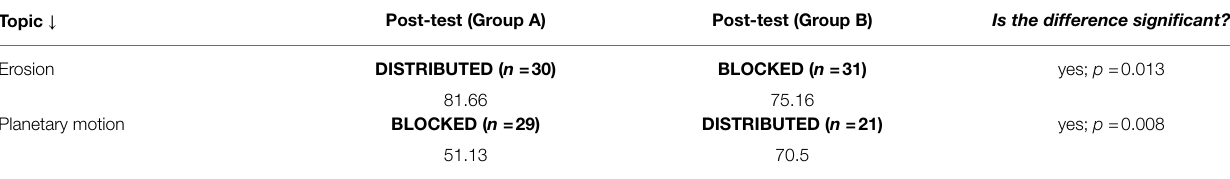
TABLE 7 | A template for socratic questions in generative retrieval practices. Overall Construct a minimum of 12 questions per simulation (SIM), including Goal illustrated text. NOTE: Levels 4 and up are